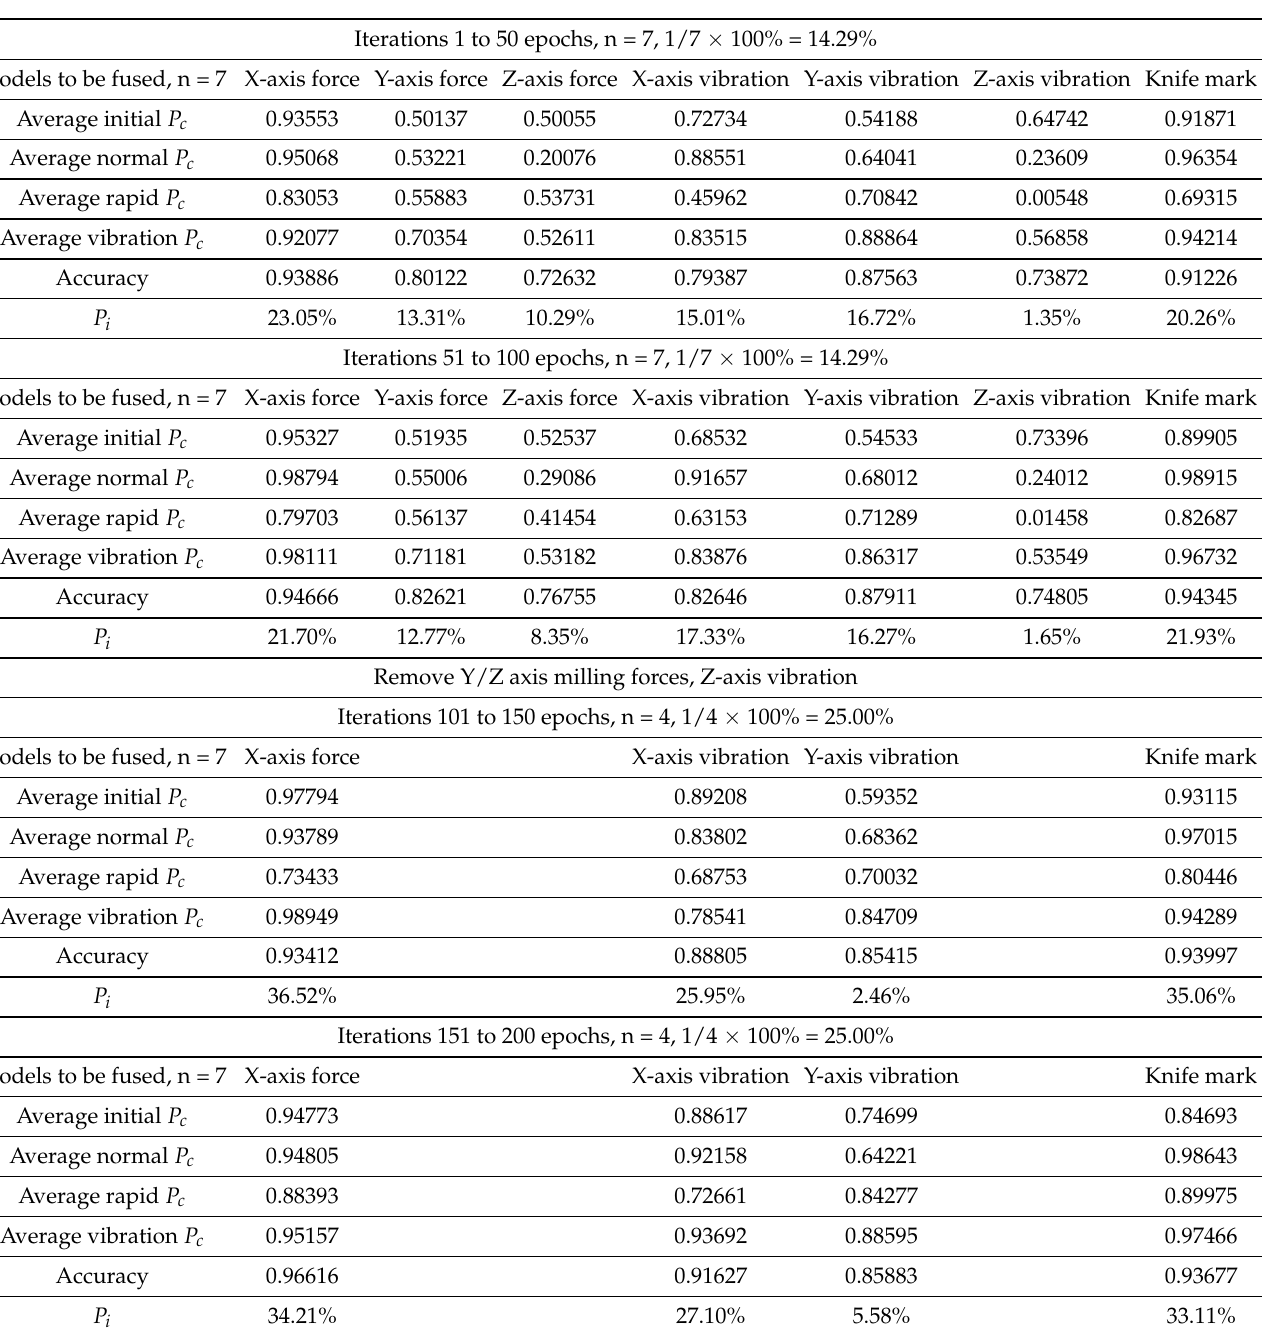
Table 4. Dynamic fusion process performance evaluation of multi-source